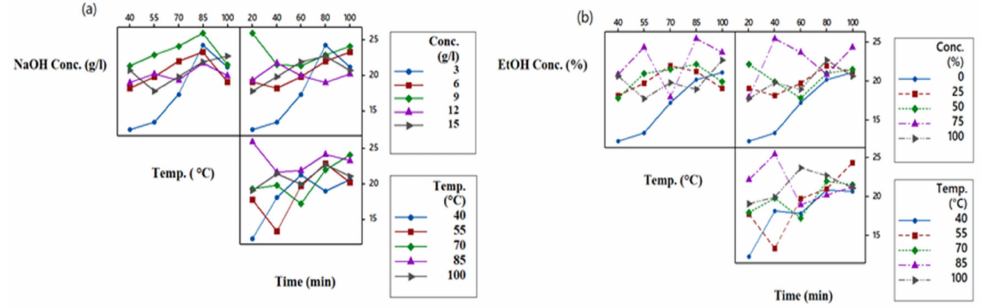
Figure 4. Interaction plot for ( a ) NaOH and ( b )